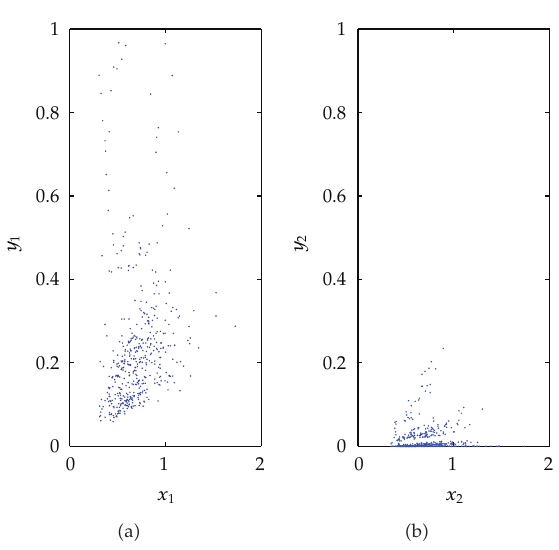
Figure 5: Population distribution scatter corresponding to Figure 4. The scatter is not around the equilibrium points of the corresponding deterministic system. There is not a stationary distribution in system (cid:2) 5.1 (cid:3) .